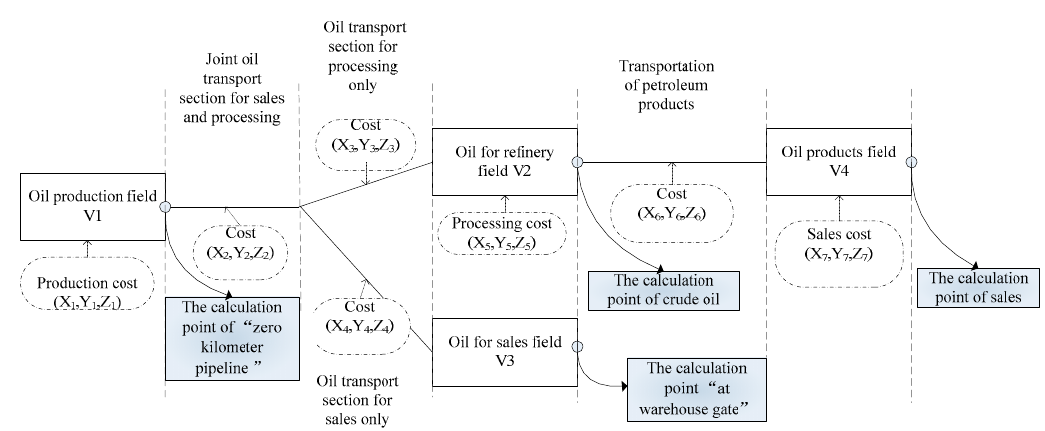
Figure 3. Main production phases of energy resources and point of calculation of energy efficiency.